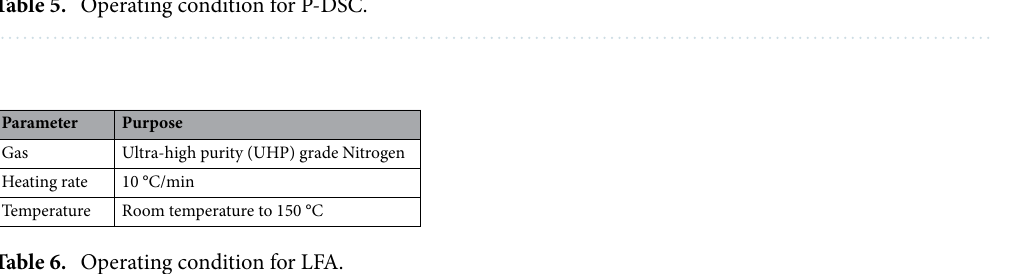
Table 6. Operating condition for